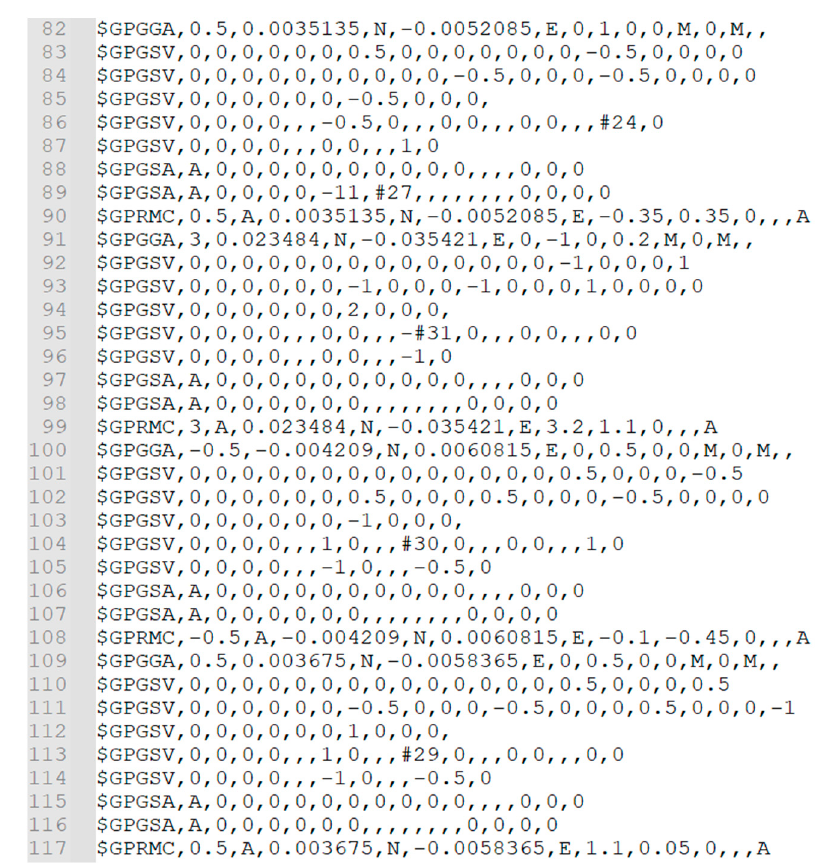
Figure A5. Different fields in the same type of line.